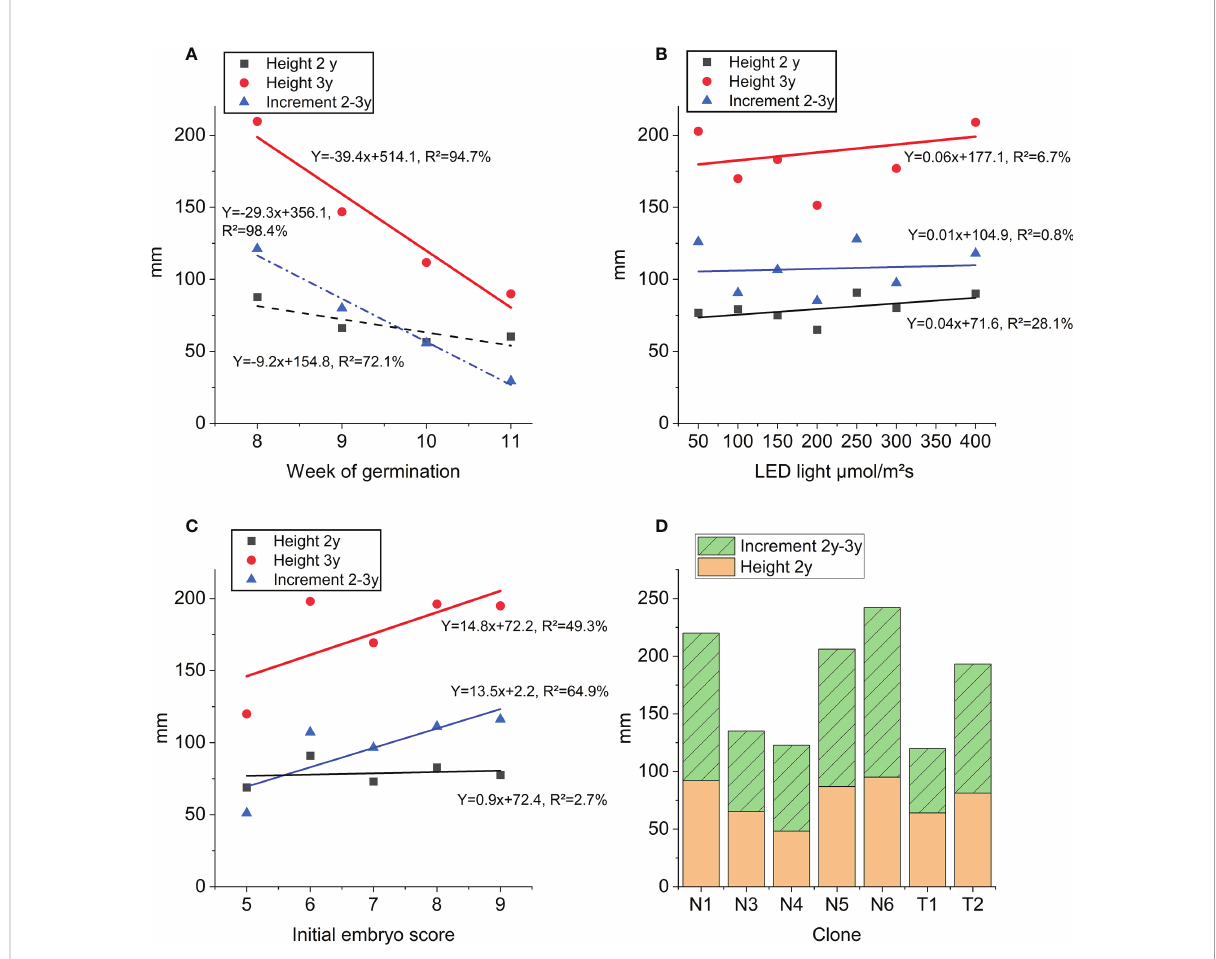
FIGURE 7 Height growth at end of step 3 nursery plant growth: 3-year height (red), 2-year height (black) and height increment (blue): (A) as function of week of germination, (B) as function of LED light intensity (applied in step 1), (C) as function of initial embryo score prior to germination (averages across all clones). Trendline equations and explanation rate (R²) for each curve and trait. (D) Average height of clones (mm) across all treatments: orange 2-year height and green increment 2-year to 3-year and stacked bars 3-year height.